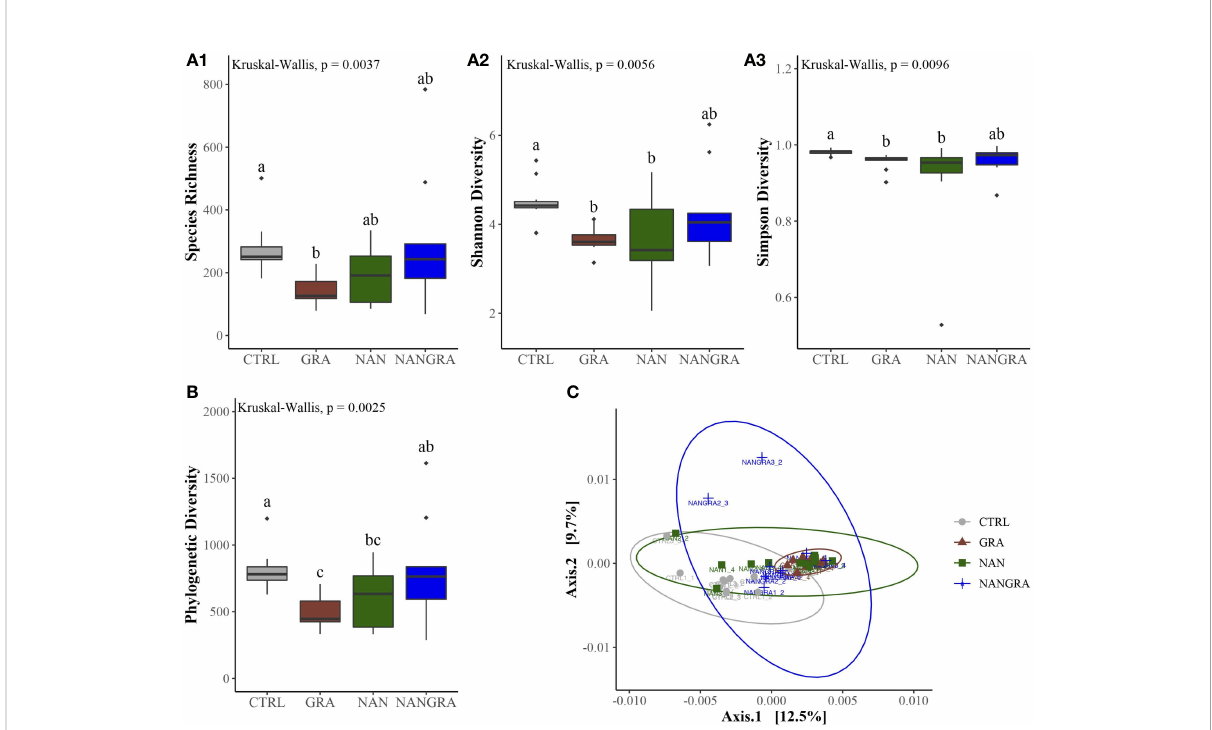
FIGURE 3 Diversity of the bacterial communities of the posterior intestine of European seabass fed the experimental diets. (A) Alpha diversity: species richness - A1, Shannon diversity - A2, Simpson diversity - A3; (B) Faith ’ s phylogenetic diversity; (C) Beta diversity visualized by a principial coordinate analysis (PCoA) plot, by employing weighted UniFrac distances. Different letters denote statistically signi fi cant differences ( P < 0.05) between the dietary treatments (CTRL, control group; GRA, Gracilaria gracilis group; NAN, Nannochloropsis oceanica group; NANGRA, G gracilis and N. oceanica blend